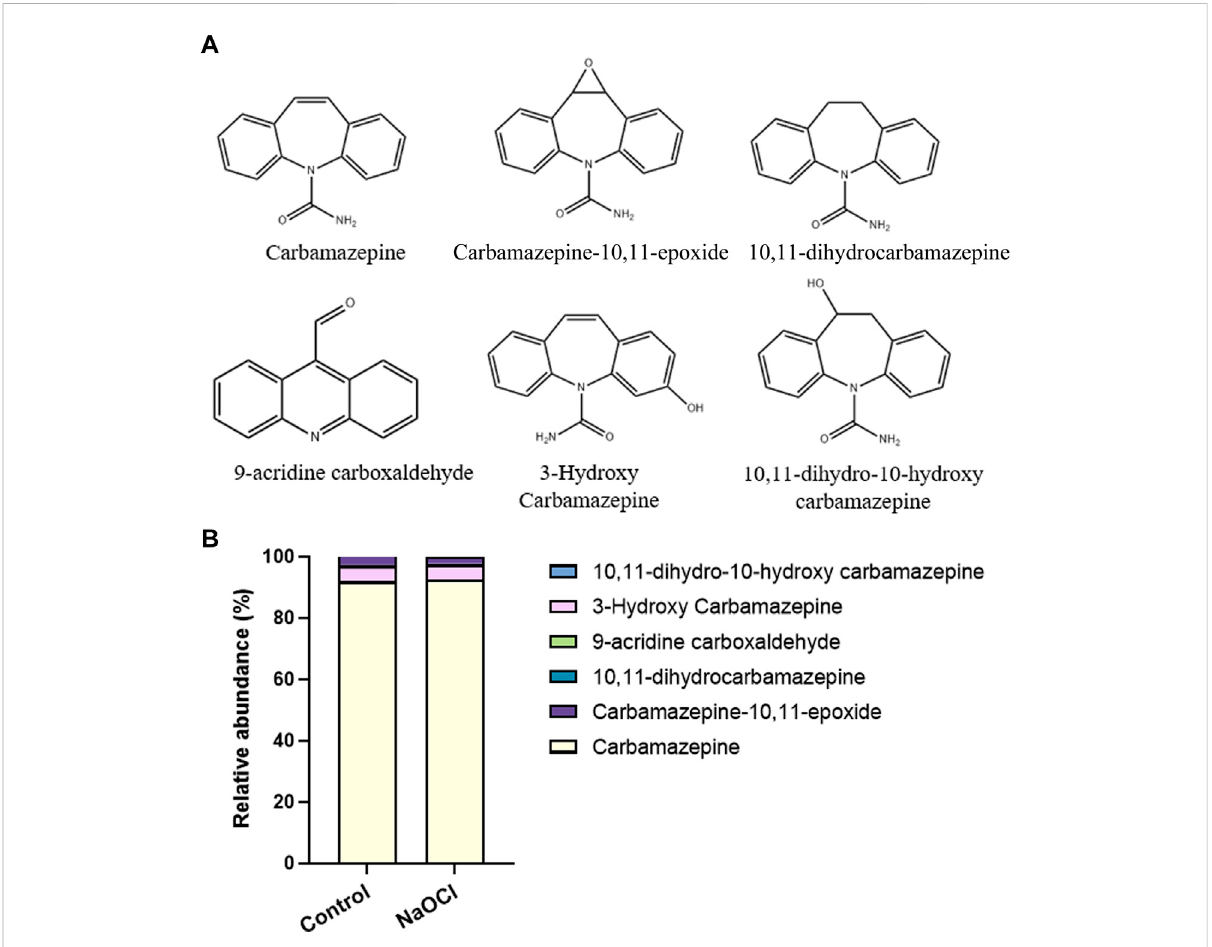
FIGURE 3 Relative abundance of CBZ and metabolites. (A) Chemical structures of CBZ and its 5 metabolites. (B) Relative abundance of CBZ and its metabolites with and without NaOCl